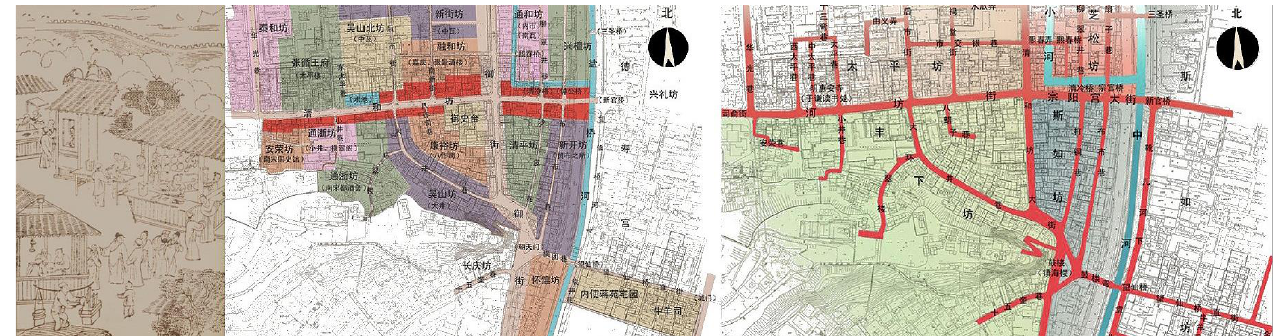
Figure 3. paintings in the past (left ), Street pattern map of southern Song Dynasty ( middle ) and Street pattern map of Ming and Qing Dynasties ( right ). (online website https://jz.docin.com/p-2811341437.html@ accessed on 22 November 2021).